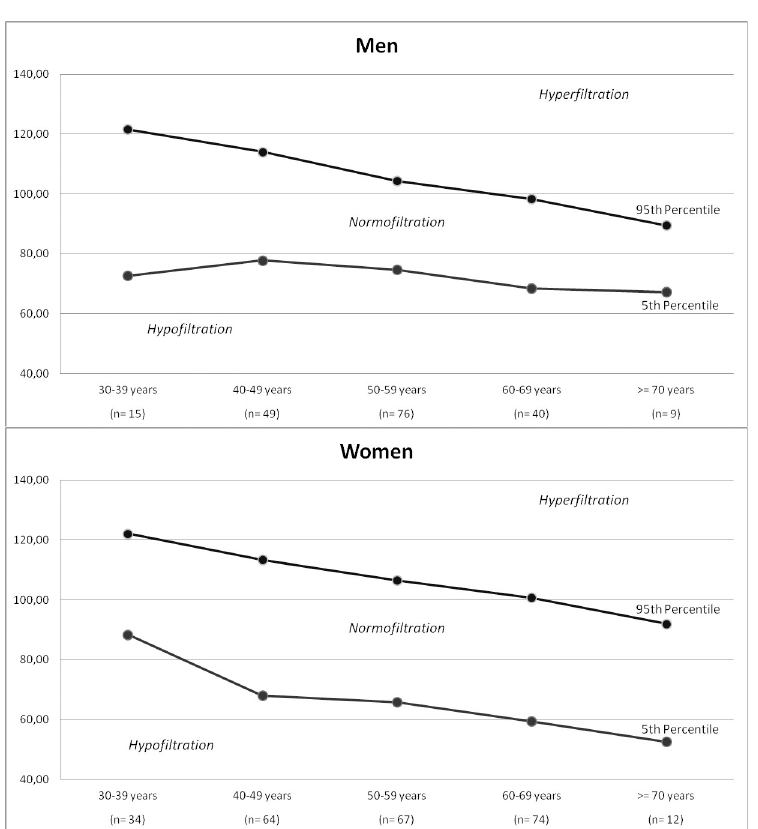
Fig 1. Distribution of estimated glomerular filtration rate (eGFR) in participants with normal fasting glucose and normal HbA1c, normotension and without kidney disease by sex and age groups. The 95th and 5th percentiles are shown in 10-year age groups. Hyperfiltration was defined as an eGFR greater than the age- and gender-specific 95th percentile and hypofiltration was defined as an eGFR less than the 5th percentile.